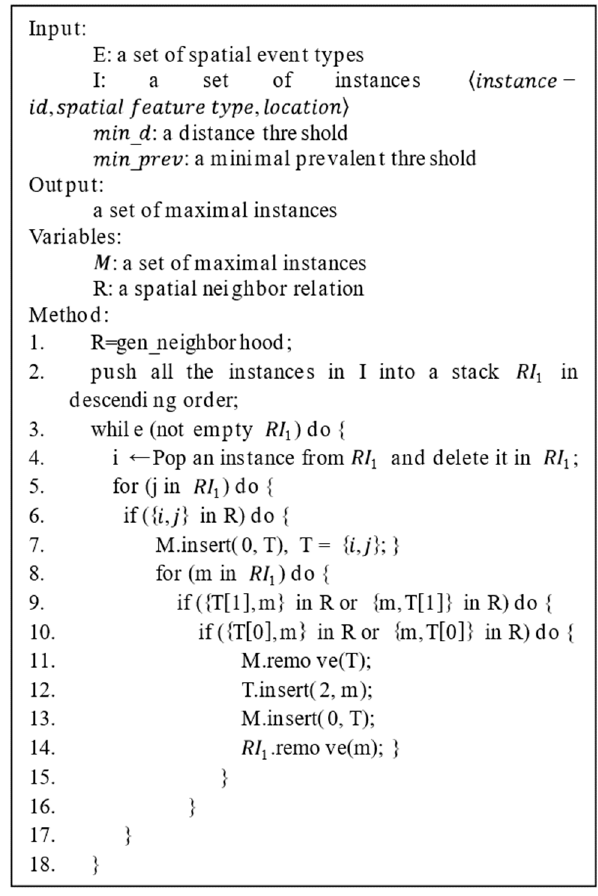
Figure 2. Algorithm for generating maximal instances.